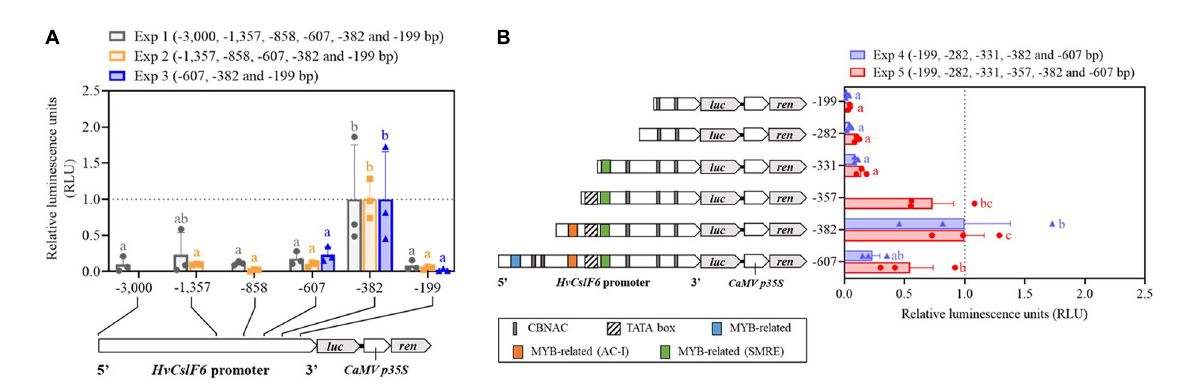
FIGURE3 Characterization of the HvCslF6 promoter using dual luciferase assays to identify region(s) response for increase in expression. Promoter activity in panels (A,B) is expressed as relative luciferase activity (luciferase/renilla ratio) and normalized to the –382 construct (with highest promoter activity, dashed gray line) on each experiment, respectively. Three independent protoplasts transfections (biological replicates) were performed per deletion construct and averaged to calculate mean reporter activity 24 h after transfection for each experiment. Negative controls ( n = 3 empty vector lacking HvCslF6 promoter) were performed in parallel and luciferase background activity subtracted from tested constructs ( n = 3 dual luciferase assays per construct, as technical replicates). (A) HvCslF6 promoter activity analyzed in six deletion constructs (from –3,000 bp full length promoter to –199 bp) using dual luciferase assays across three independent experiments (Exp1, Exp2, and Exp3). Letters above each construct indicate significant differences within each experiment determined by one-way ANOVA ( p -value 0.041, Exp1; p -value < 0.01, Exp2 and p -value 0.027, Exp3) followed by Tukey’s multi-comparison test. Error bars represent standard error ( n = 3). (B) HvCslF6 promoter activity of 5 (cid:48) HvCslF6 promoter deletion constructs from –607 bp to –199 bp in barley protoplasts. Gray bar indicates CBNAC calmodulin-binding NAC motif, blue bars indicate MYB-related motifs, yellow bars denote MYB-related AC-I motifs, green bars indicate secondary wall MYB-responsive element, (SMRE) and the diagonally stripped bar denotes predicted location of the TATA box consensus sequence. Different letters above each construct (i.e., a,b) indicate significant differences determined by one-way ANOVA ( p -value < 0.01) followed by Tukey’s test. Error bars represent standard error ( n =